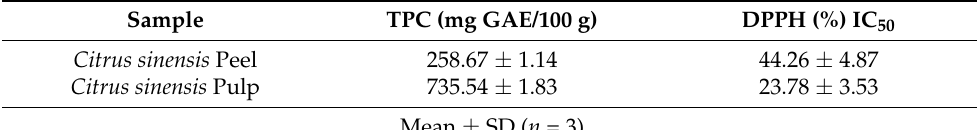
Table 4. Total phenolic content and DPPH